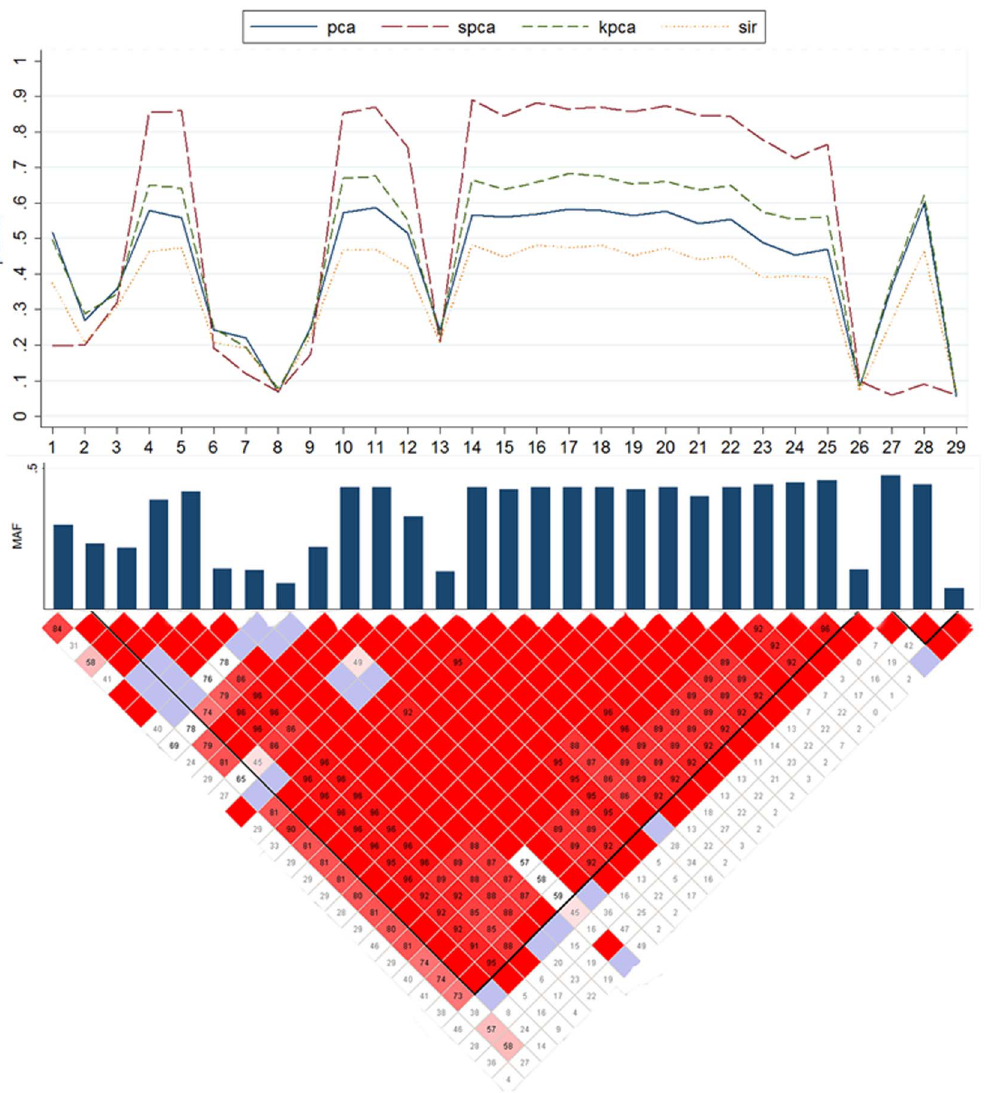
Figure 3. Powers of the causal SNP in Scenario B2 based on the CLPTM1L gene. The top plot shows the power (y-axis) of each method over the locations (x-axis) of the causal SNPs. The bar-plot shows the MAFs of all SNPs. The LD structure of the 29 SNPs is shown by the heat plot in the bottom of the figure, in which the red scale indicates the value of R 2 (1=red, 0=white).